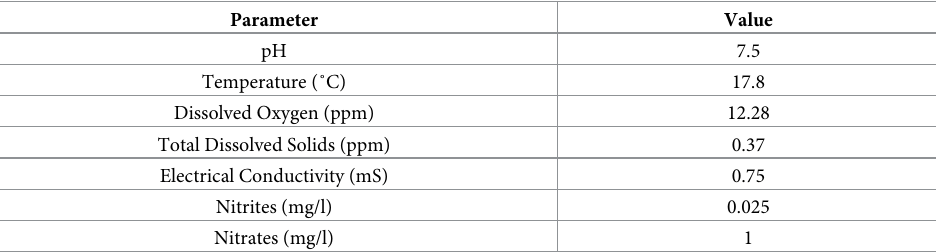
Table 1. Water physical and chemical parameters of the sampled